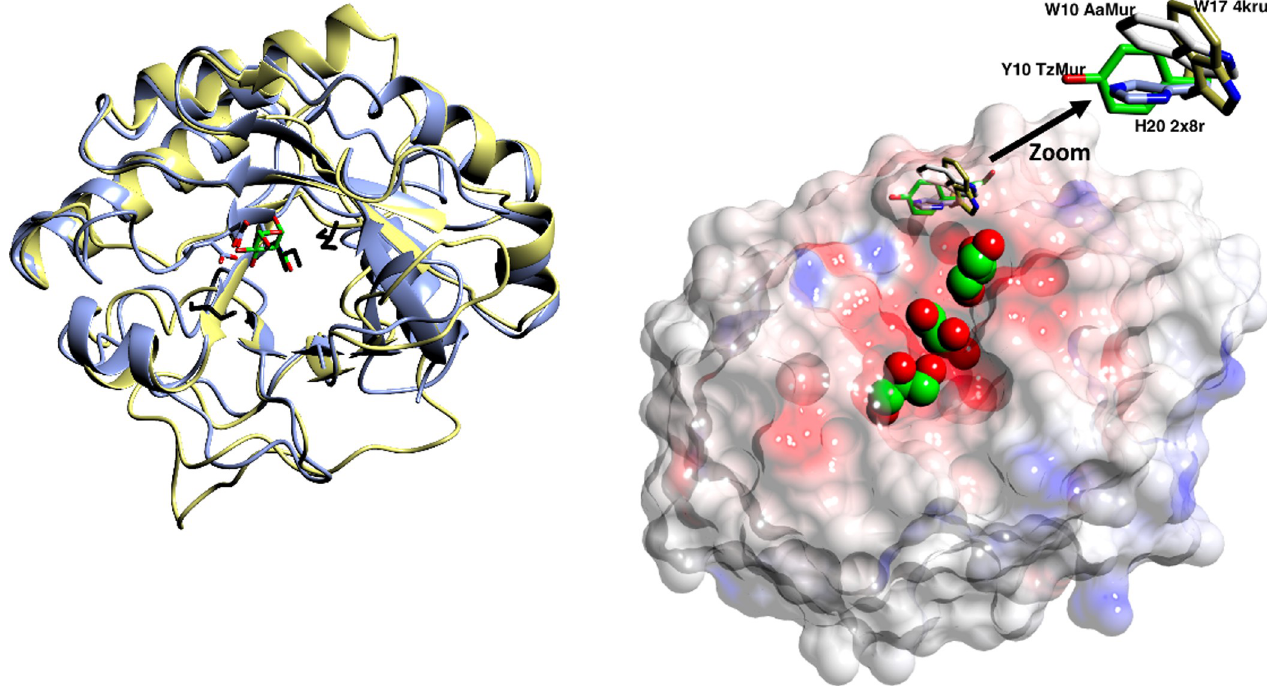
Fig 8. (a) Superposition of Tz Mur (ice blue) on 4KRU (yellow), showing one of glycerols (black) superimposing on part of NDG (green) bound in the catalytic domain of the endolysin from Clostridium perfringens phage phiSM101 (4KRU), both in the vicinity of active site D and E. The other two glycerols most likely indicate the positions where peptidoglycan would be in a complex. (b) Surface representation of Tz Mur with the binding site indicated with glycerol molecules. The aromatic residues corresponding to Tyr10 of Tz Mur in superimposed structures of Aa Mur, 2X8R and 4KRU all have different conformations, with flexibility at this location potentially facilitating optimal positioning of peptidoglycan for processing. The aromatic residues are shown as cylinders, green for Tz Mur, yellow for Aa Mur, ice blue for 2X8R and coral for 4KRU. Glycerols from Tz Mur are shown as spheres, they indicate the position of binding pocket.